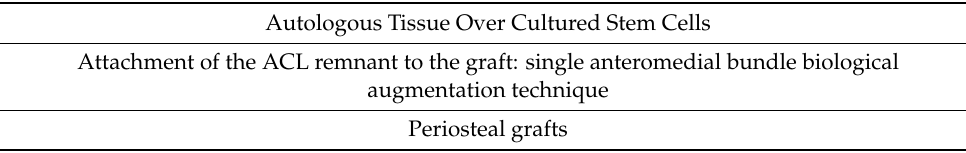
Table 3. Autologous tissue used in anterior cruciate ligament